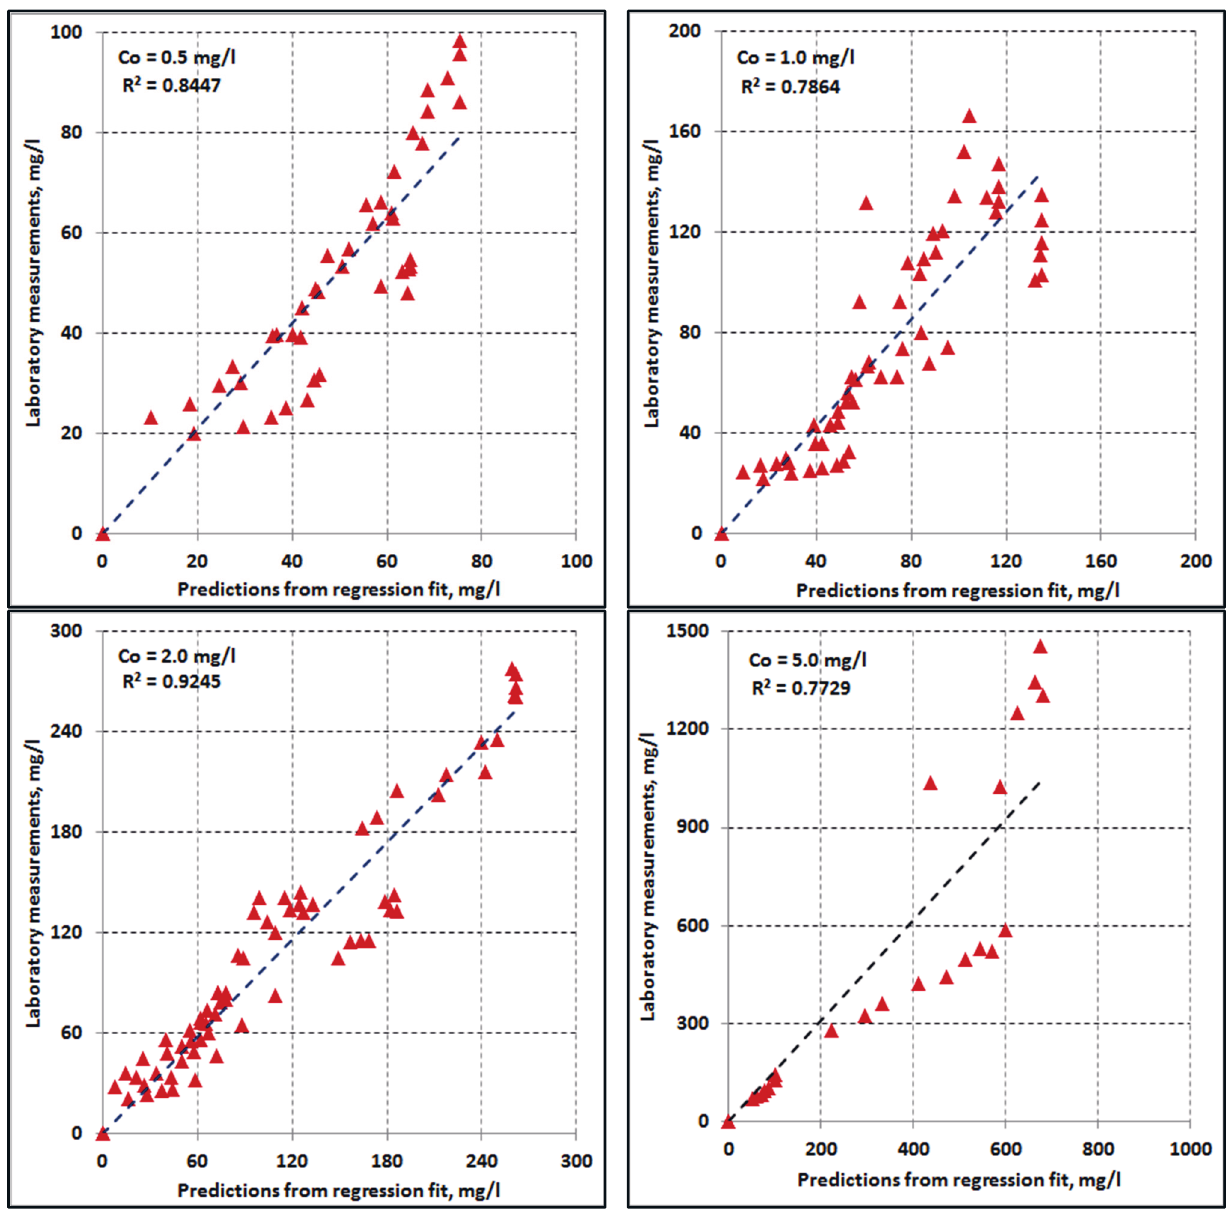
Figure 8. Correlation between laboratory measurements and multivariate regression predicted bromoform formation at different chlorine dosages for all temperature